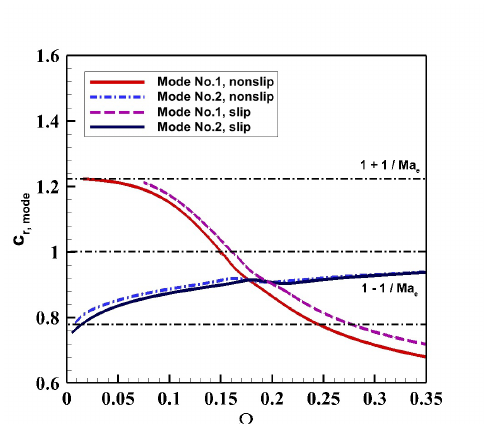
Figure 7. Mode No. 1 and Mode 2 tracking, with slip and no-slip B.C.s. The Y -axis c r , mode ∝ α r , representing the phase velocity distribution of the corresponding wave modes as a function of Ω = R ω , Ma e = 4.5, x ∗ = 0.139 m, R = 1000.152, and Re x = 1.0003 × 10 6